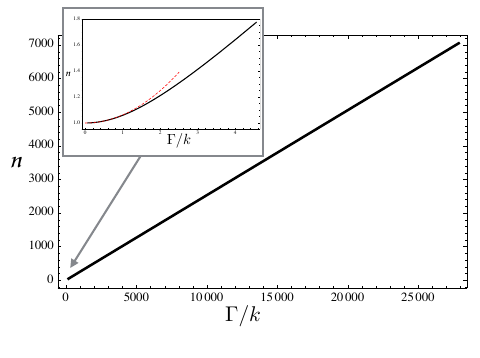
Figure 3 . Plot of the RG (cid:13)ow invariant n , de(cid:12)ned in (2.10), versus deformation parameter (cid:0) =k , for the boomerang RG (cid:13)ows. The inset shows excellent agreement with the perturbative result given in (2.10) for (cid:0) =k (cid:28) 1.